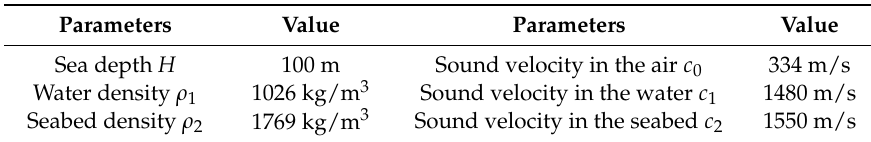
Table 1. The marine environmental simulation